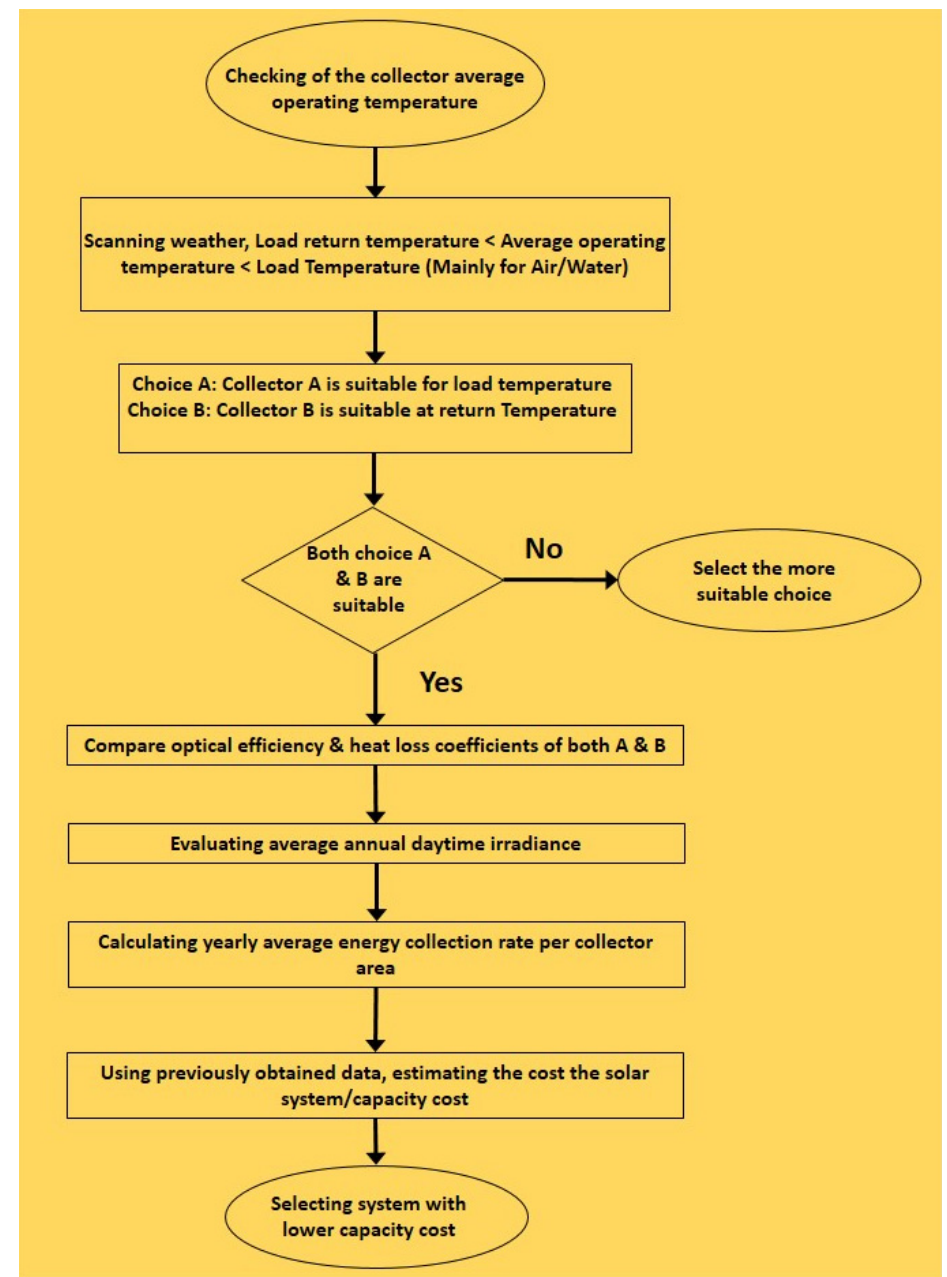
Figure 1. Steps to select a preferable solar collector for a SHIP system, modified from TR-253-1356 by SERI